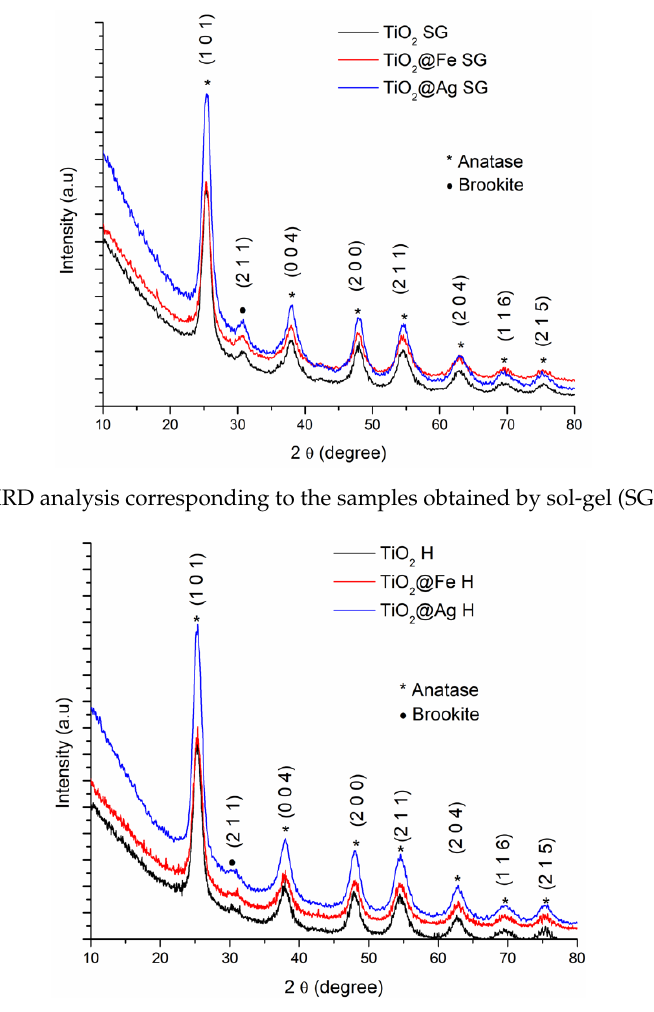
Figure 4. XRD analysis corresponding to the samples obtained by microwave-assisted hydrothermal (H) method. Table 1. FWHM for the characteristic plane (1 0 1) of the anatase phase. Sample